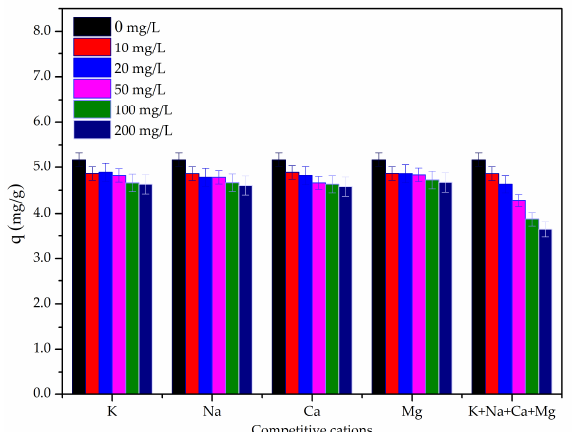
Figure 8. Effects of common cations on the adsorption capacity (pH = 5, t = 8 h, T = 25 °C, C 0 = 100 mg/L, n = 100 rpm).